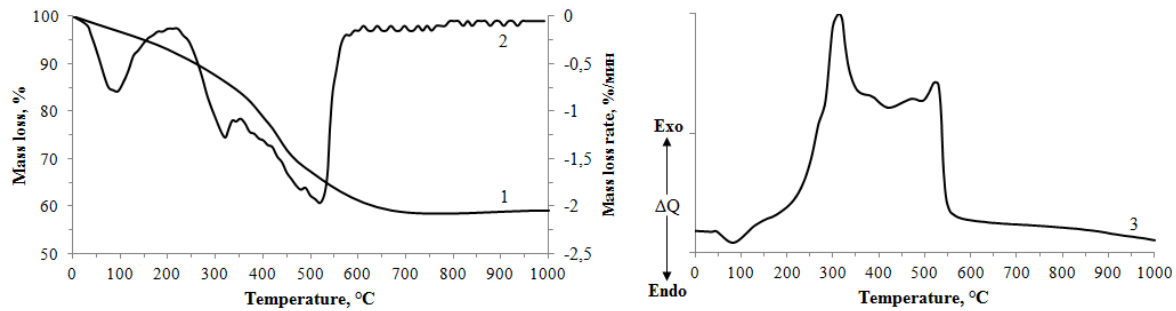
Figure 2: Curves of thermal analysis of a humic sorbent: 1 - TG; 2 - DTG; 3 – DTA.